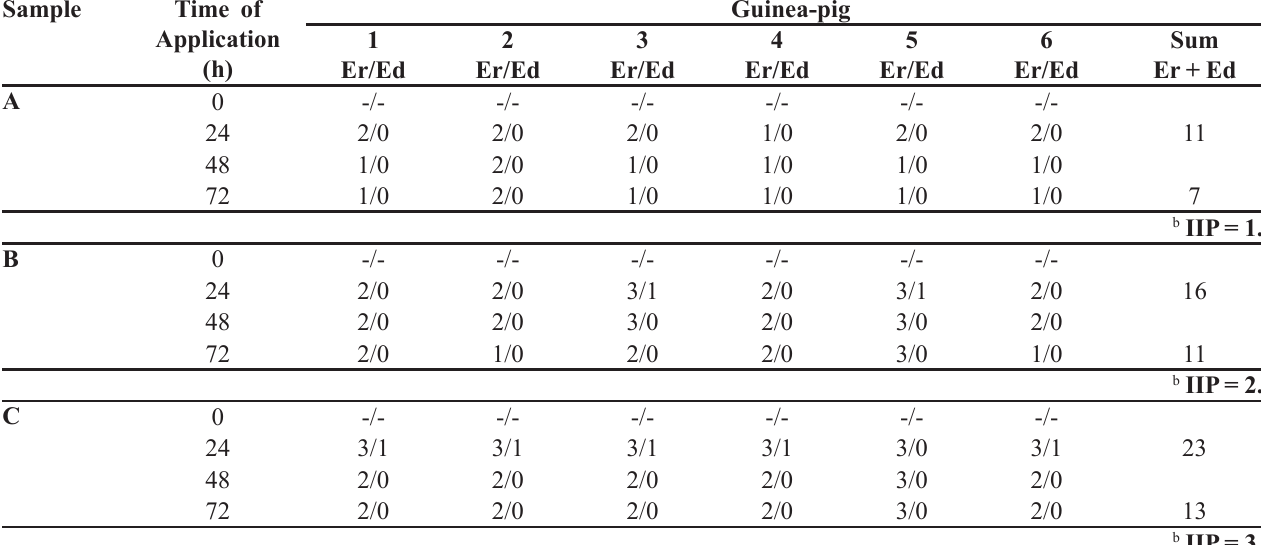
TABLE IV - Edema (Ed), Erythema (Er) and Primary irritation index (IIP ) a measured from tests conducted after application of 3 samples (A, B, C) of cosmetics, using 6 guinea-pigs (1 to 6) for each group of samples, performed in May 1989